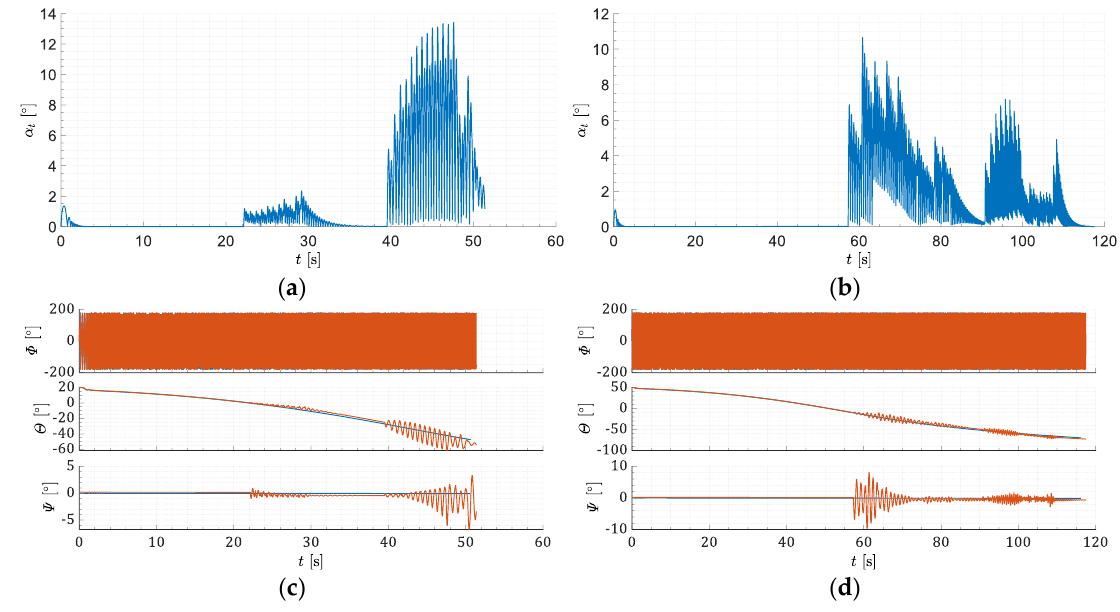
Figure 12. Total angle of attack α t time histories ( a ) Θ 0 = 20 ◦ ( b ) Θ 0 = 50 ◦ and Euler angles vs. time ( c ) Θ = 20 ◦ ( d ) Θ = 50 ◦ . Figure 12 . Total angle of attack 𝛼 𝑡 time histories (a) 𝛩 0 = 20° (b) 𝛩 0 = 50° and Euler angles vs. time (c) 0 0 𝛩 0 = 20° (d) 𝛩 0 = 50°